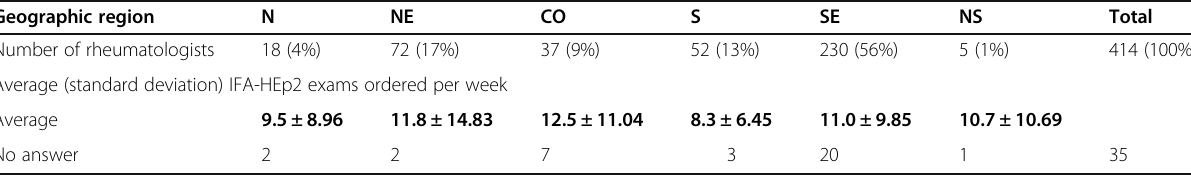
Table 3 Frequency of HEp-2 IFA tests requested per week by rheumatologists in the five Brazilian macro-regions Geographic region N NE